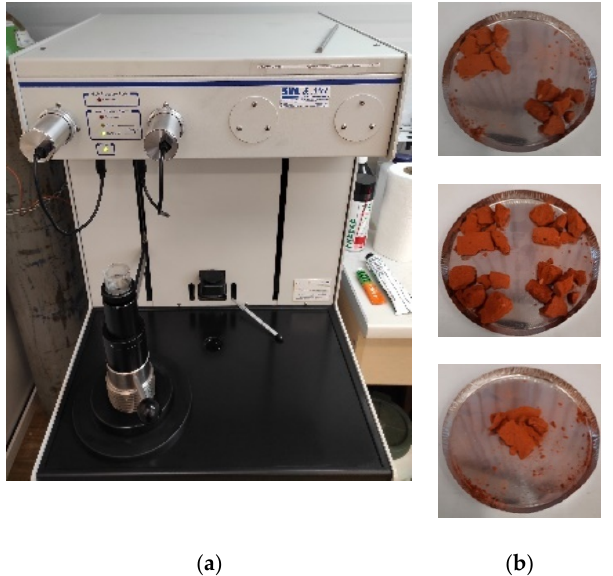
Figure 5. Porosimetry test stand: ( a ) the mercury intrusion porosimeter used in the test, ( b ) samples selected for the test.